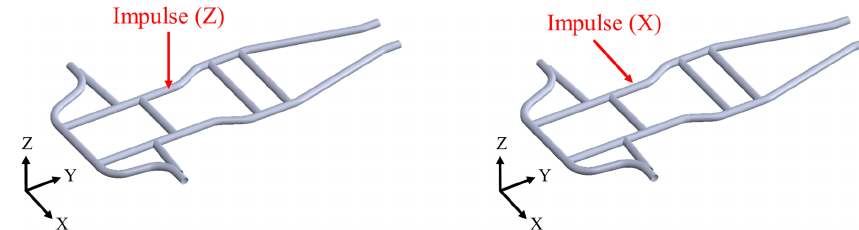
Figure 26. Vertical and horizontal suspension frame excitation location plan.